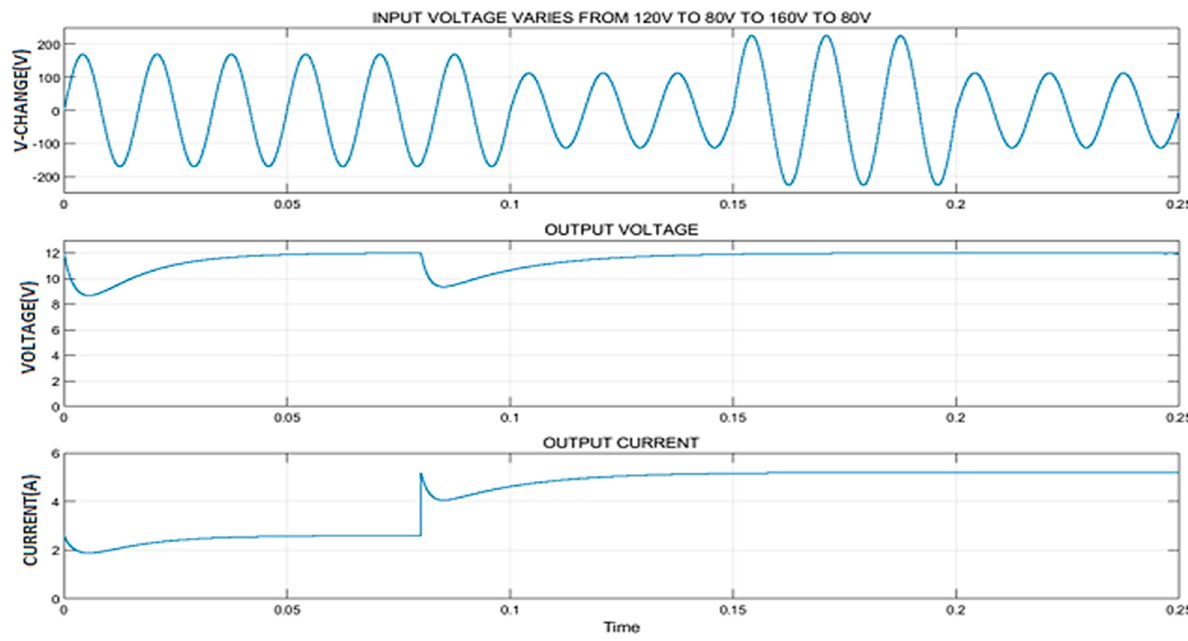
Figure 13. Closed-loop three-level cascaded controller simulation result.